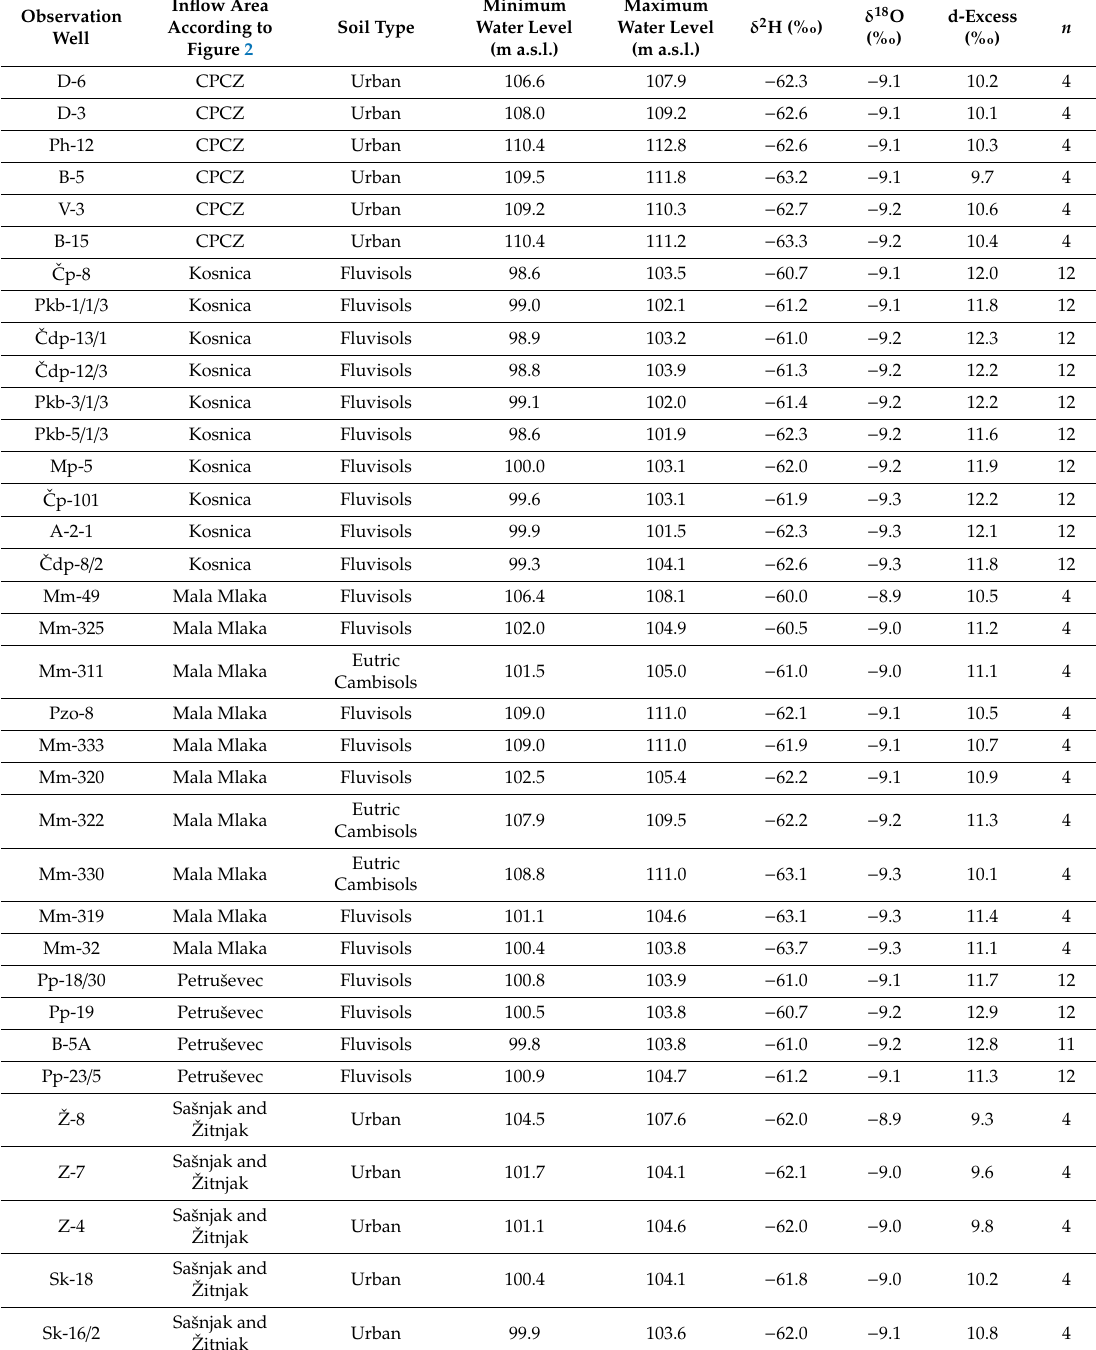
Table 1. Hydrogeological, pedological, and water stable isotope data (average values of δ 18 O, δ 2 H, and d-excess) used in the analysis (minimum and maximum water levels registered between 2000 and